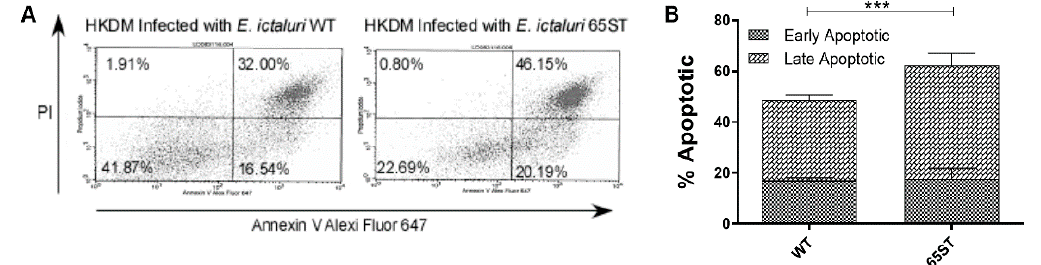
Figure 4. Caspase activities in HKDM cells infected with E. ictaluri WT and T3SS mutant 65ST. Staurosporine treated HKDM were used as a positive control. Cultures were harvested at 1, 3 and 5 h post-infection. Values are expressed as means ± standard deviation of 4 di ff erent observations. Asterisks indicate significant di ff erences following one-way analysis of variance with Tukey’s post-test to compare the mean of each treatment with every other treatment. Asterisks indicate significant di ff erence between treatments. (* = p ≤ 0.1, ** = p ≤ 0.01, *** = p ≤ 0.001).